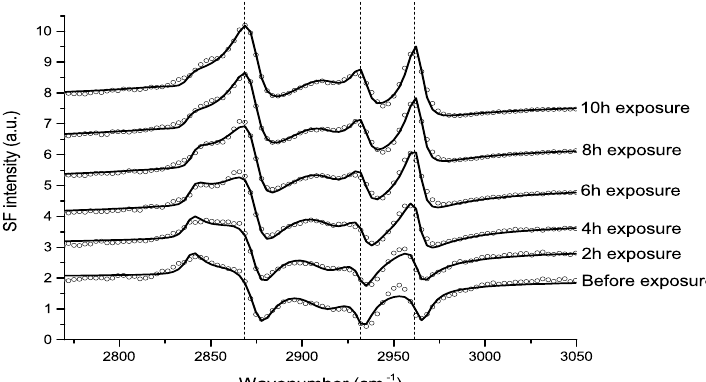
Figure 20. Time evolution of VSF spectra of the octadecanethiol (ODT) covered copper during exposure to dry air. Experimental data and fitted spectra are presented as empty circles and lines, respectively. The CH 3 symmetric, Fermi resonance, and antisymmetric stretches from ODT molecules are marked with the dash lines. The spectra are offset for clarity. Reprinted with permission from reference [115], Copyright 2011, American Chemical Society.